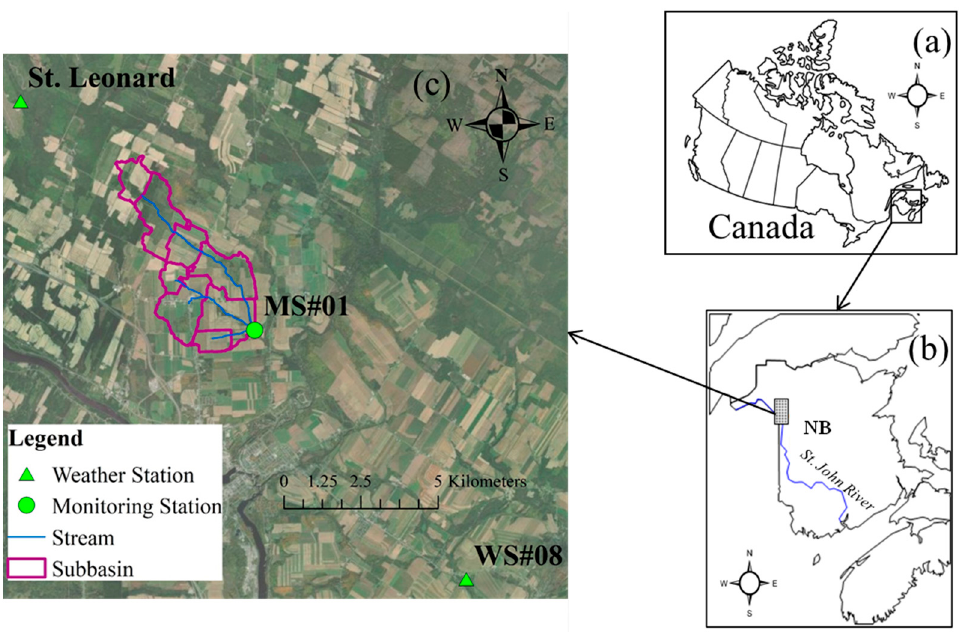
Figure 1. ( a ) Canada boundary, ( b ) New Brunswick boundary, and ( c ) locations of the BBW (including subbasins) and water-monitoring station #01, as well as weather station #08 and the weather station at St. Leonard.